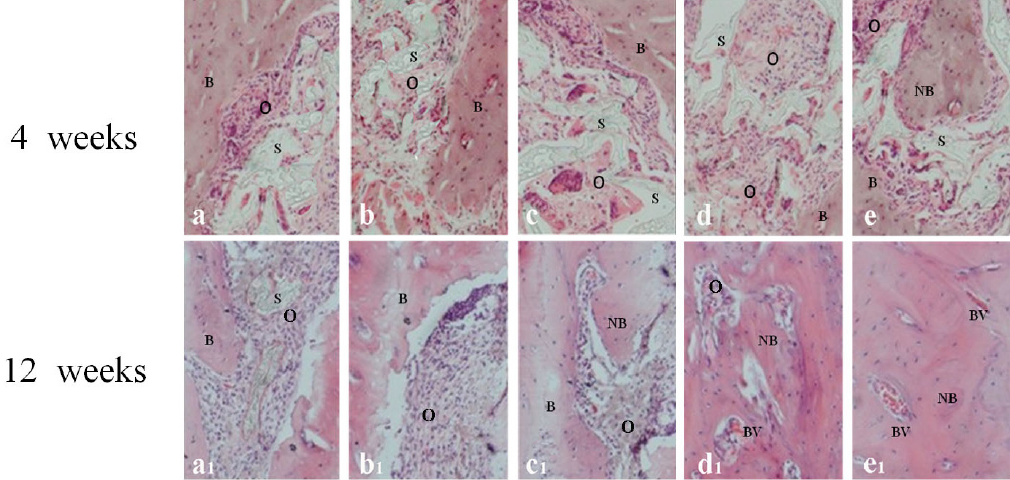
Figure 6. Tissue slices of different mandibular implants at weeks 4 and 12 stained with hematoxylin and eosin (H&E). a ( a ) Scaffold alone; b ( b ) BMSCs/scaffold; c ( c ) BMSCs/ 1 1 1 bFGF/scaffold; d ( d ) BMSCs/BMP-2/scaffold; e ( e ) BMSCs/bFGF/BMP-2/scaffold. B, bone; 1 1 S, scaffold; O, osteoid matrix; NB, new bone; BV, blood